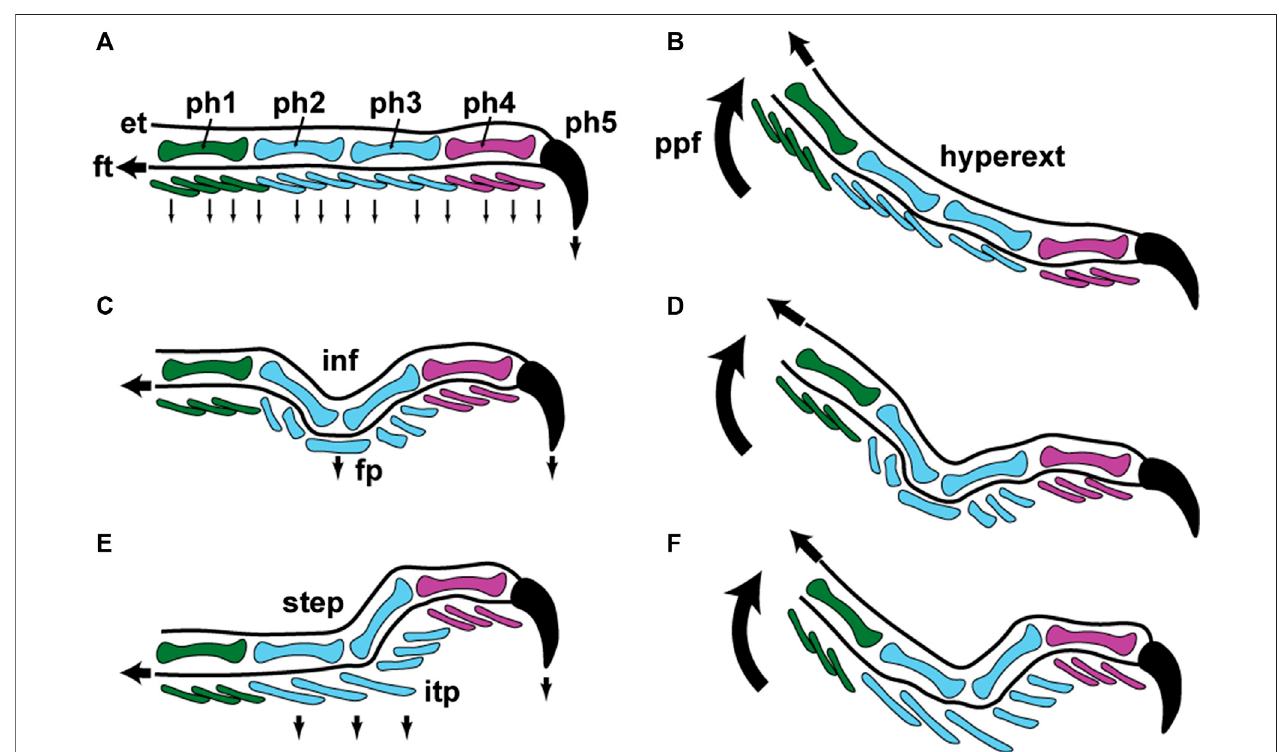
FIGURE 6 | Schematic representations of lizard digit kinematics during locomotion and inferences about how incipient toe pads became incorporated into this pattern. Color conventions for the phalanges (ph1 – ph5) and ventral scales of the digit are identical to those in Figure 5 , panels (B), (D) ; (G), (I) ; and (M), (O) . (A) and (B) fourth digitofhindfootinlateralviewwhenappliedtothesubstratum (A) and whenbeingraisedfromcontactwithit (B) .Inpanel (A) thedigitisapplied tothesubstratum withthe fi rstfourphalanges(ph1 – ph4)alignedwitheachotherandthe fi fth(ph5)anditssurroundingclawsheathbeingdrivenintothesubstratumviacontractionof